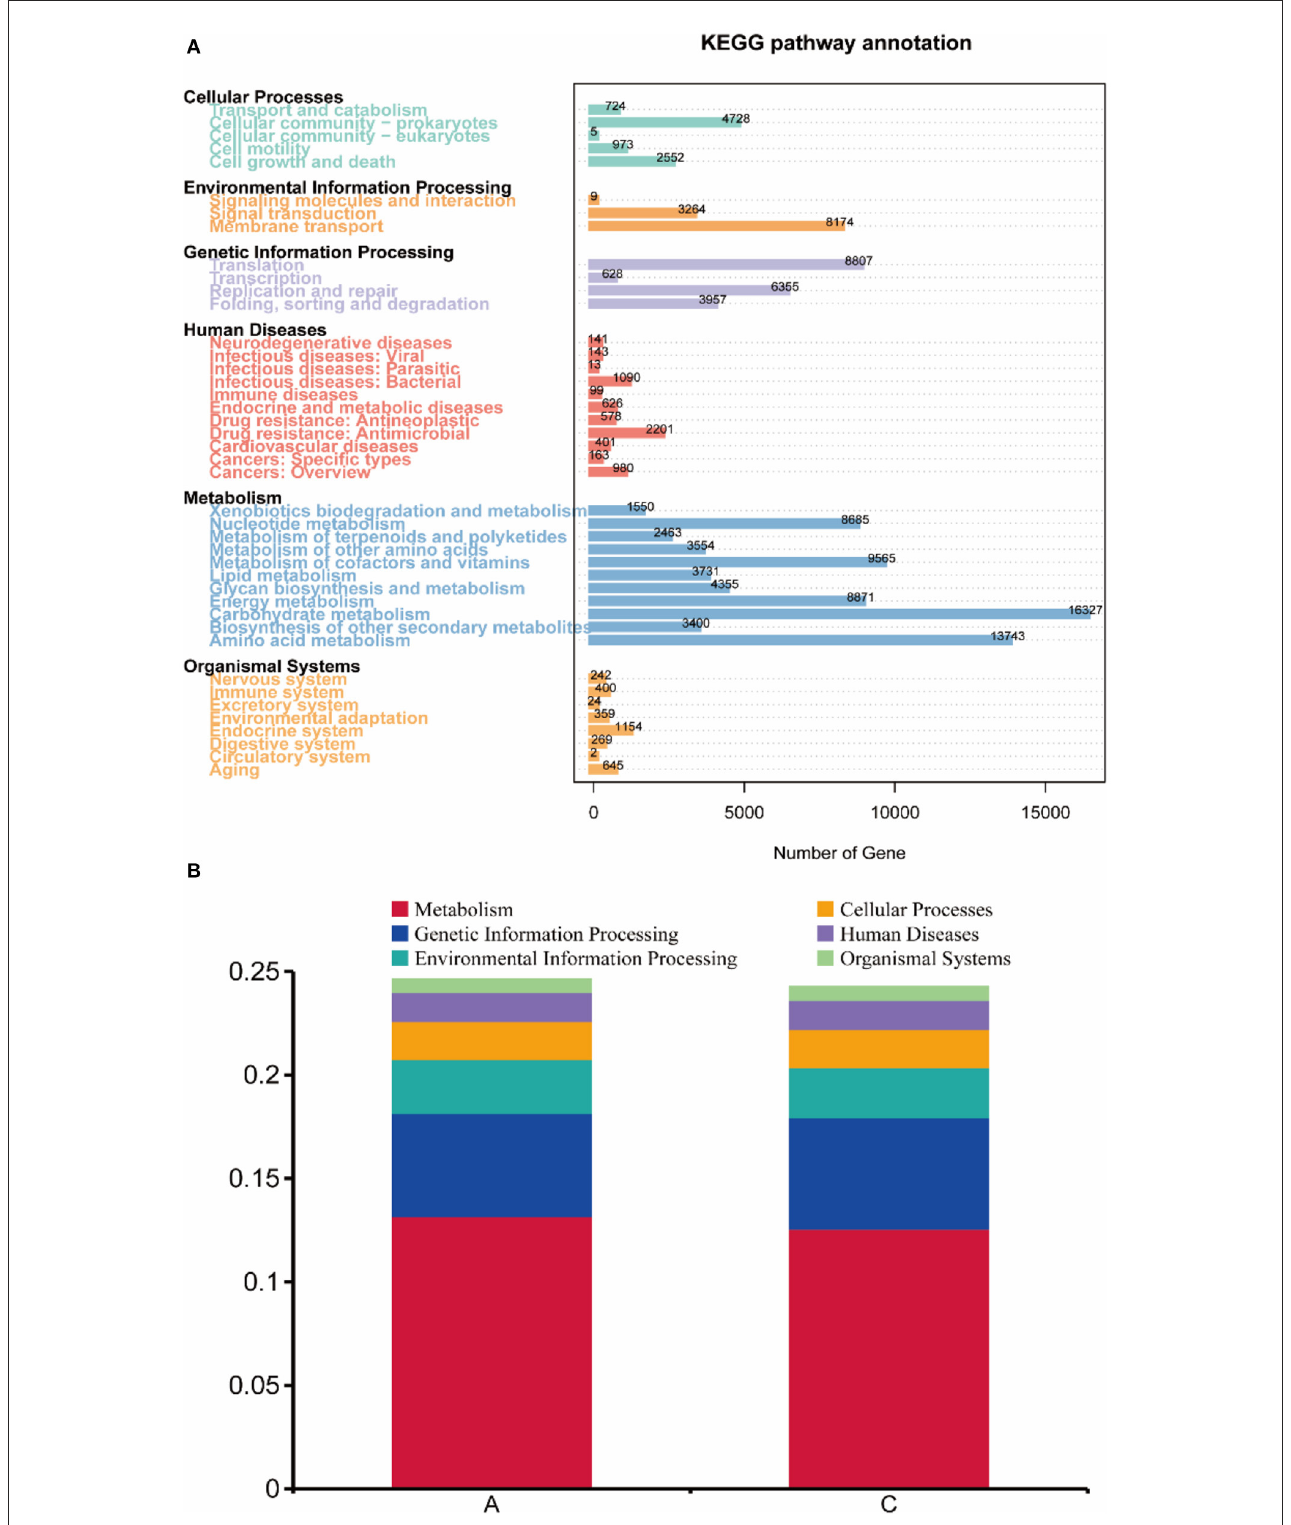
FIGURE5 (A) Statistical map of gene number. The number of genes annotated into the KEGG metabolic pathways in rumen microorganisms of the two groups was calculated. (B) Functional annotation abundance graph (level 1).